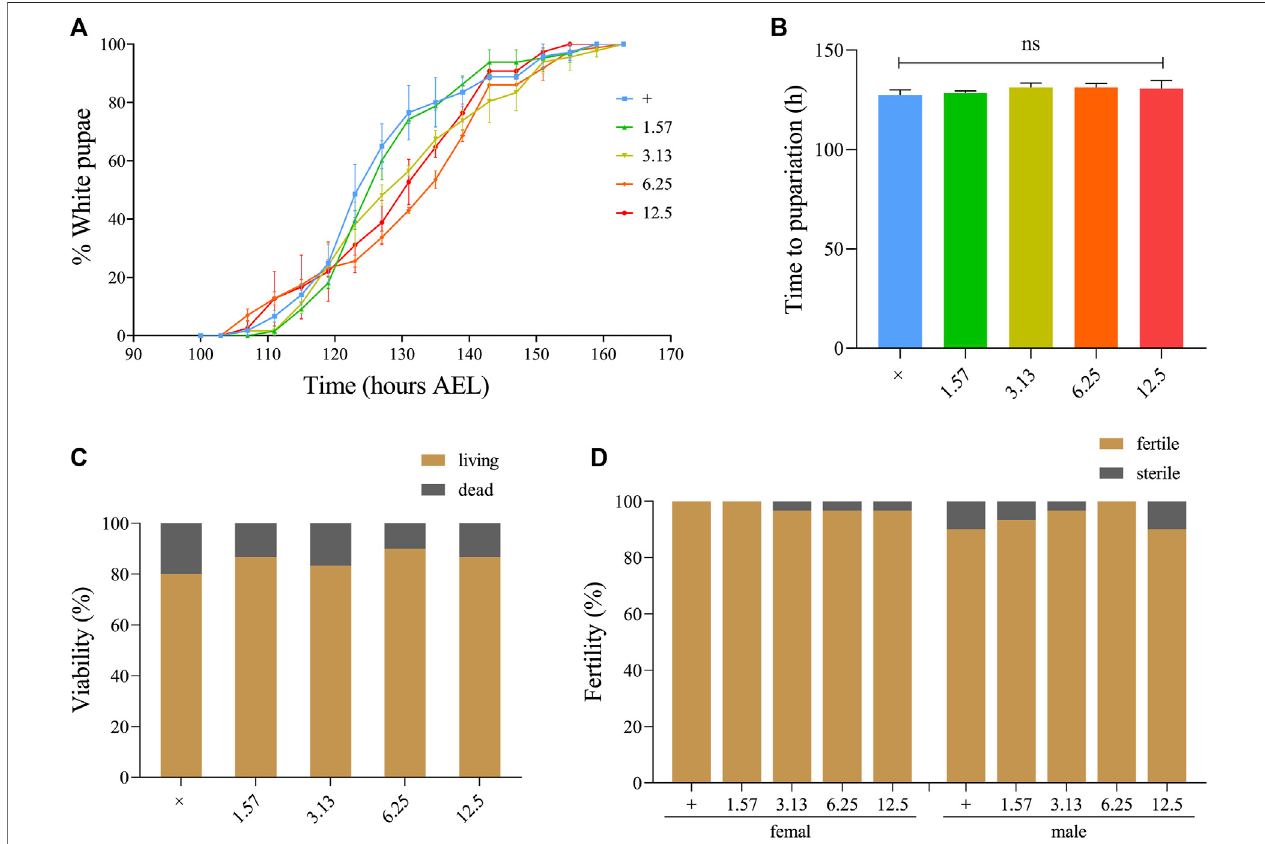
FIGURE 5 | Effect of XFZYD on the development, viability, and fertility of Drosophila . Statistical analysis of the white pupae rate [ (A) , n = 3] and time to pupariation [ (B) , n =3]of w 1118 larvaefedcontrolfood,orXFZYD-addedfoodareshown.Fortimetopupariationstatistics,aone-wayANOVAwithBonferroni ’ smultiplecomparison test was applied, and ns indicates no signi fi cant difference. For the histogram of viability [ (C) , n = 30] and fertility [ (D) , n = 30] in w 1118 adults, the chi-squared test was applied ( n = 30).